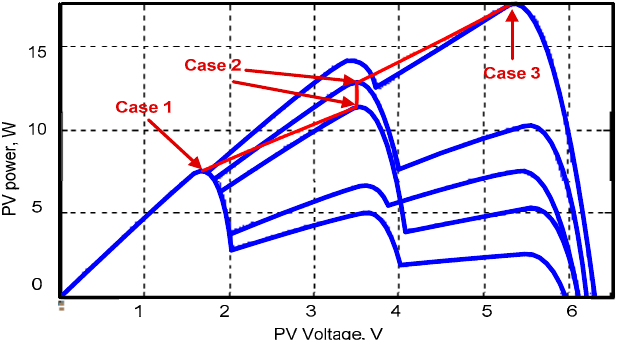
Figure 1. P-V characteristics of partially shaded photovoltaic (PSPV) arrays.